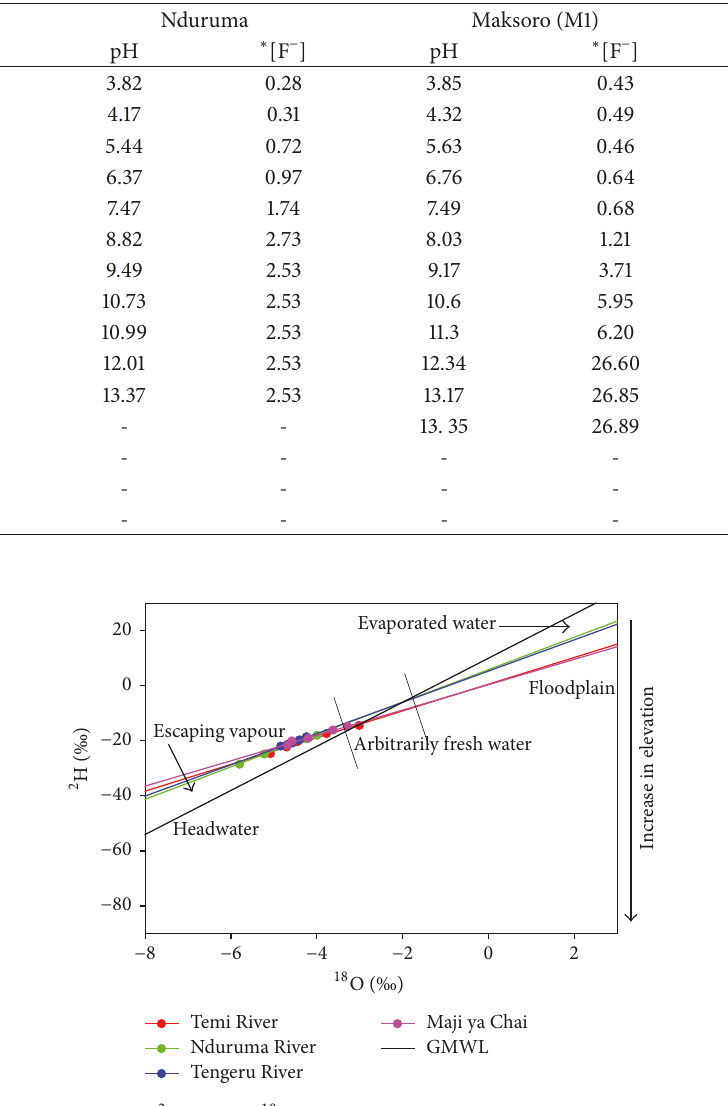
Figure 2: A plot of 𝛿 2 H versus 𝛿 18 O indicating an increase in evaporation